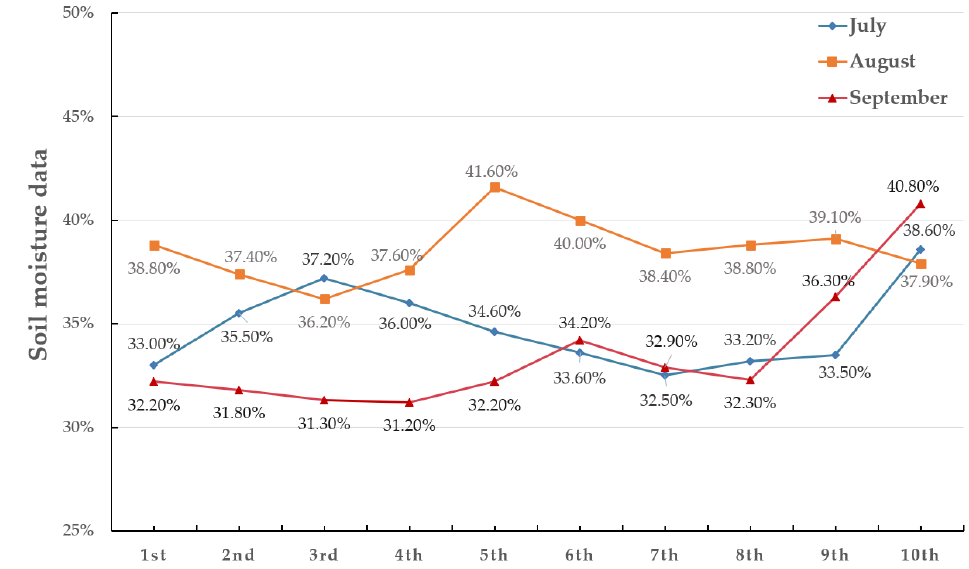
Figure 6. Soil moisture data for July–September 2021 in Suzhou City, Anhui Province.